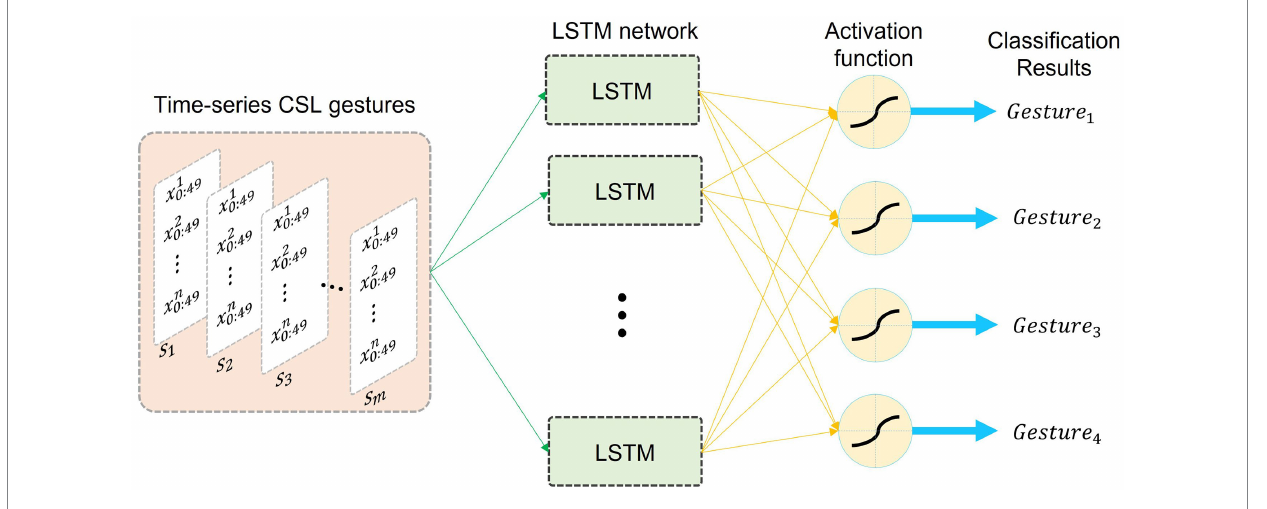
FIGURE 8 The LSTM model used in the experiment.